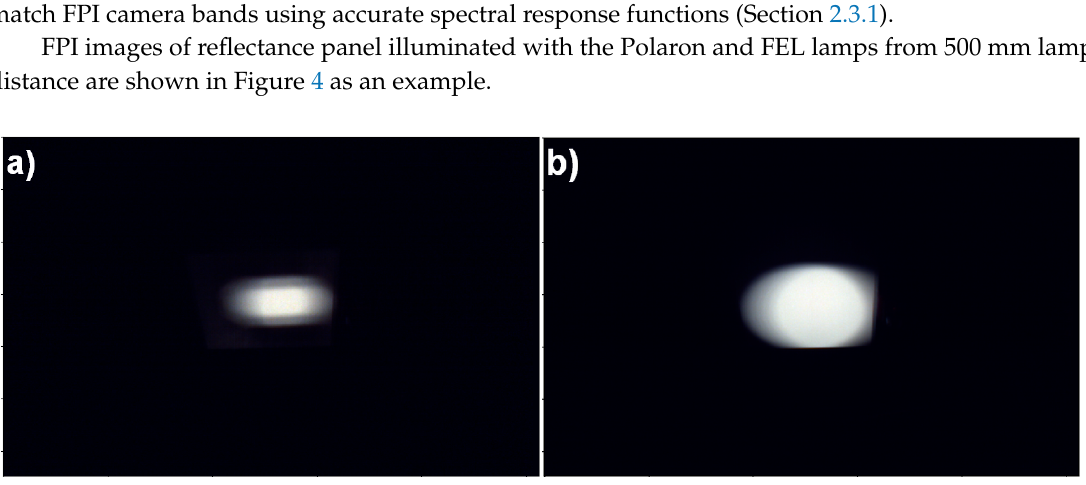
Figure 4. Example FPI images of the reflectance panel illuminated with ( a ) Polaron and ( b ) FEL lamp, 500 mm lamp distance. Only the centre part of the illuminated area was used for calibration.